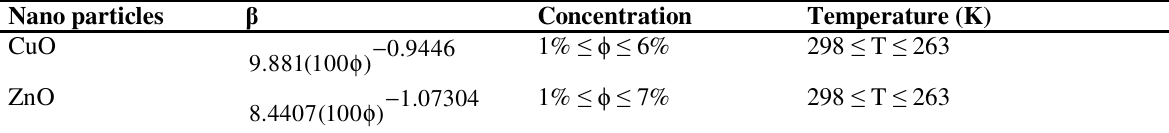
β values of of CuO and ZnO nanoparticles material